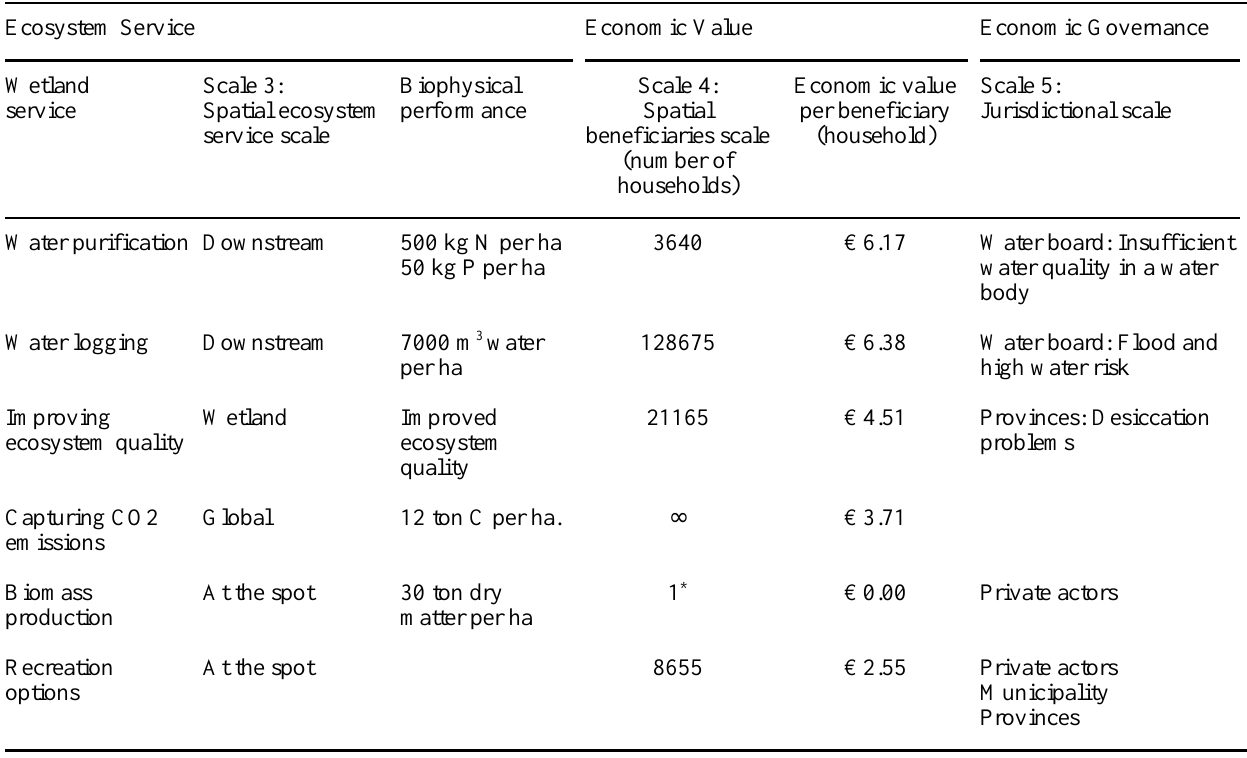
Table 1. Scale value and governance issues attached to the implementation of commercial